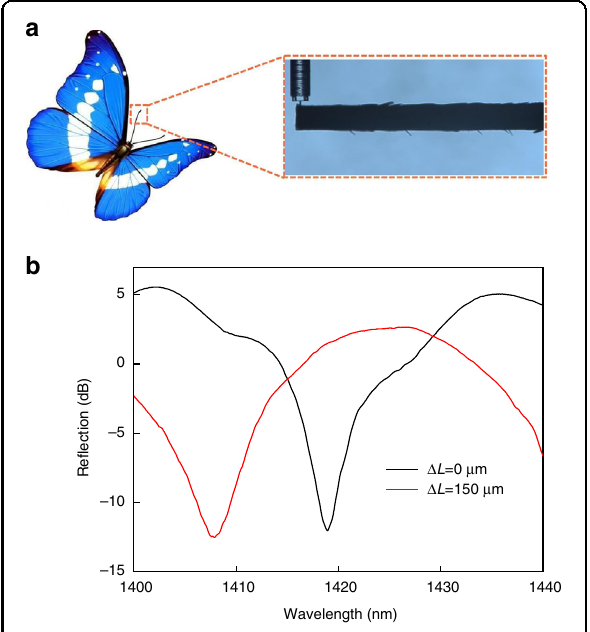
Fig. 8 Butter fl y feeler measurement. a CCD image of pushing against butter fl y feeler of the proposed sensor. b Evolution of re fl ection spectrum of the sensor with de fl ection of butter fl y feeler from 0 to 150 μ